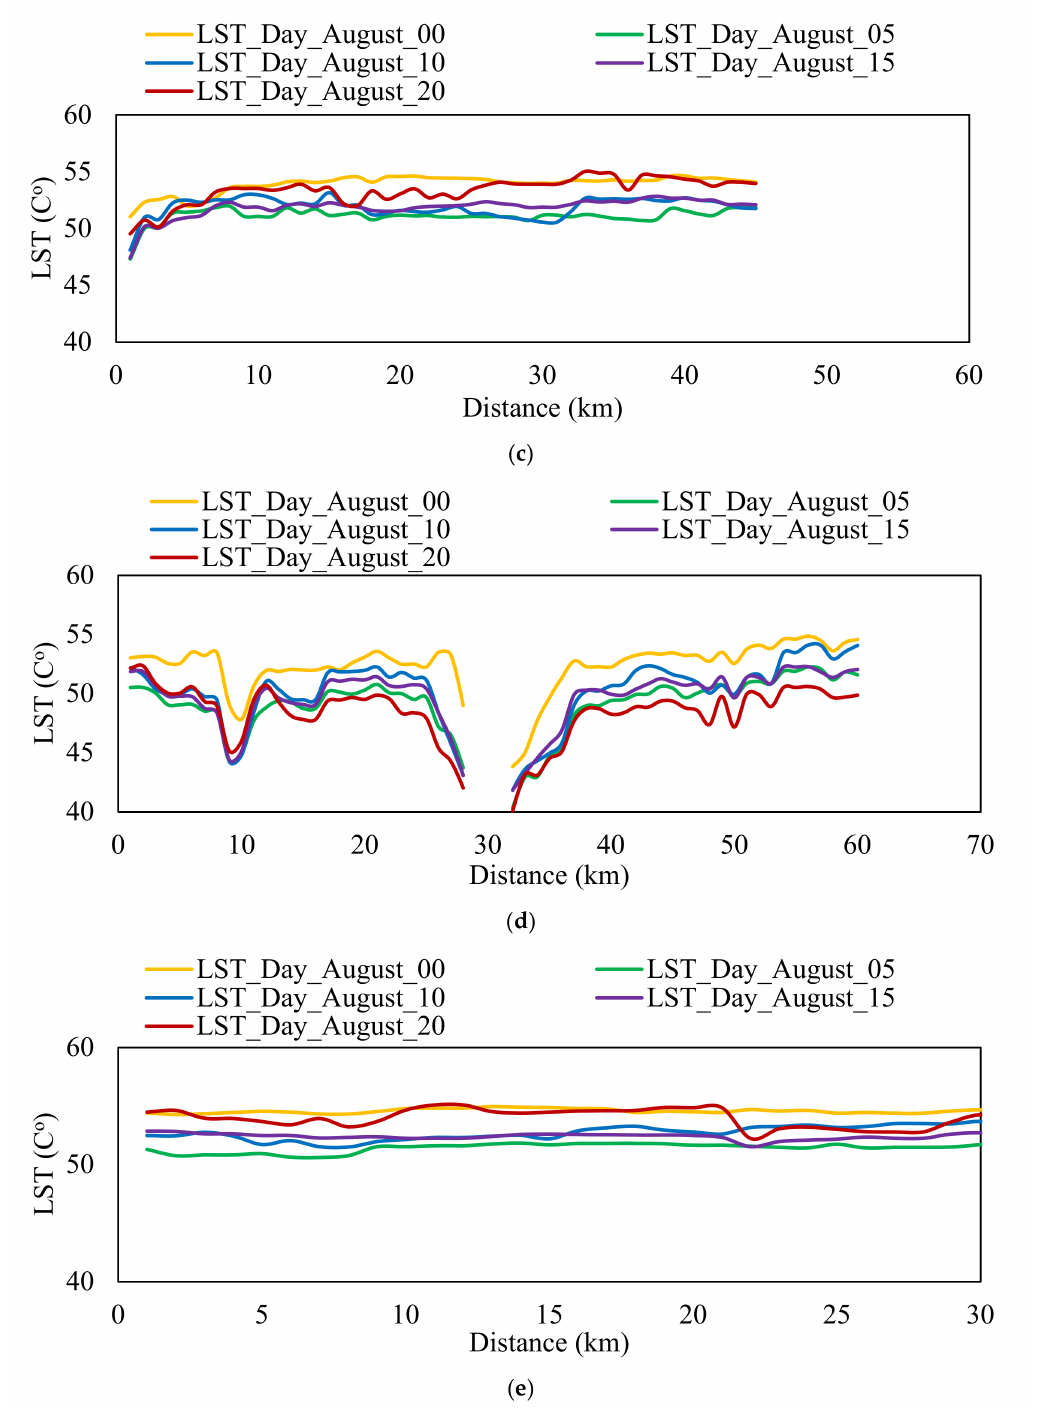
Figure 18. Temporal Profiling of Daytime LST in Summer Seasons. ( a ) Profile 1; ( b ) Profile 2; ( c ) Profile 3; ( d ) Profile 4; ( e ) Profile